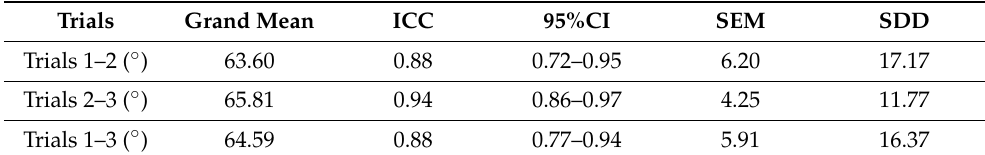
Table 5. Intra-rater reliability of the double inclinometer method for the assessment of thoracolumbar range of